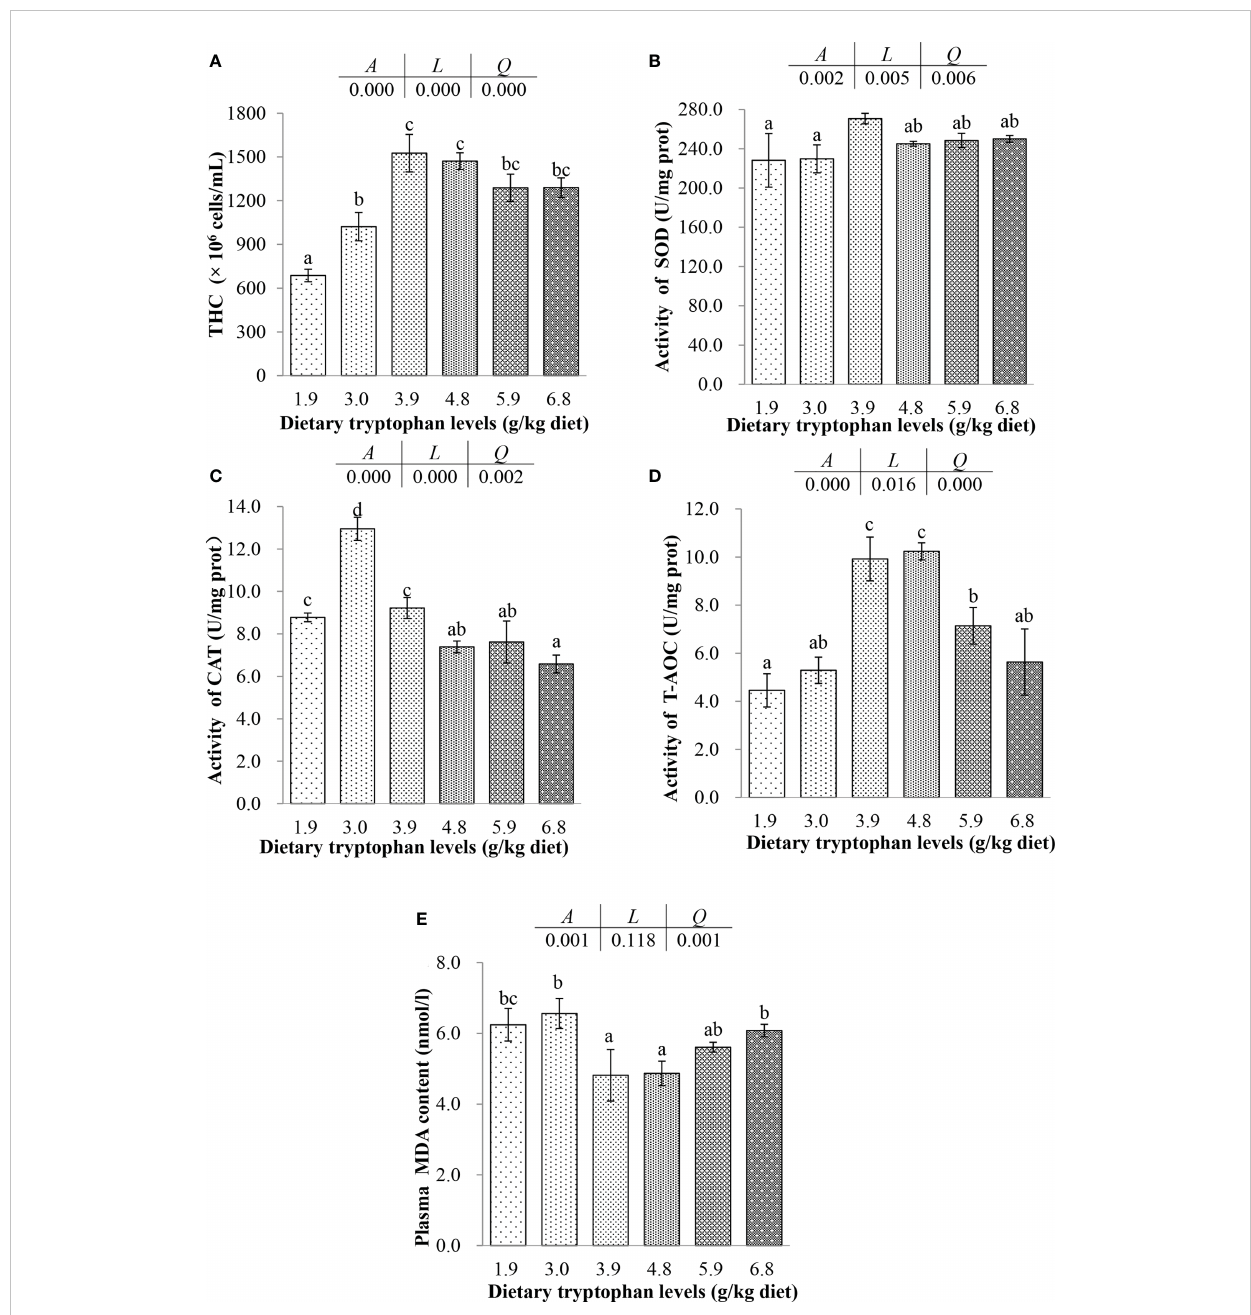
FIGURE 2 Effects of dietary tryptophan different levels on total hemocyte count and hematologic antioxidant parameters of blood in C argus (means ± S.D. of three replications). Bars with different letters differ signi fi cantly among the treatments ( P < 0.05). (A) Total hemocyte count (THC); (B) Superoxide dismutase (SOD); (C) Catalase (CAT); (D) Total antioxidant capacity (T-AOC); (E) Malondialdehyde